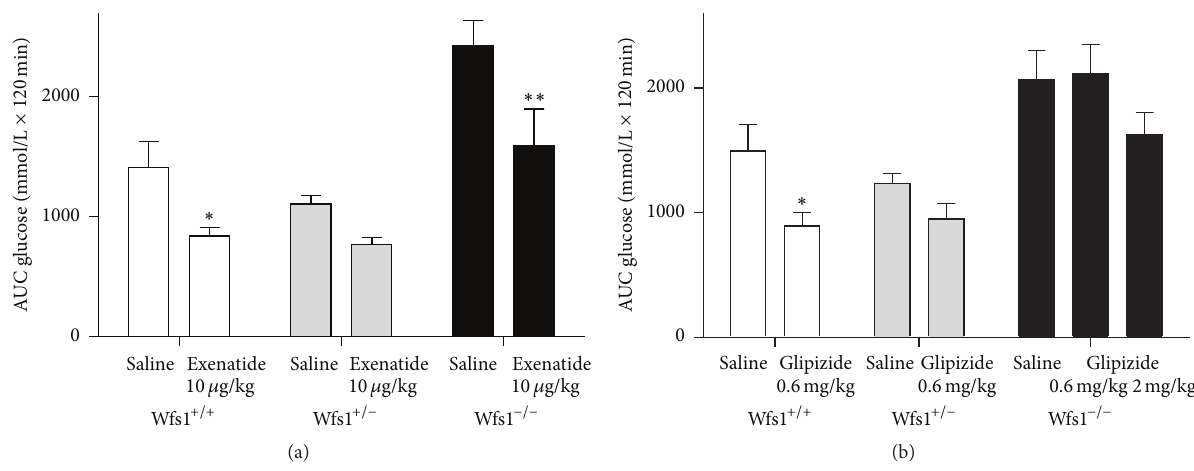
Figure 4: Effect of treatment with exenatide (a) and glipizide (b) on glucose AUC during IPGTT. Wfs1 +/+ , white bars; Wfs1 +/− , grey bars; Wfs1 −/− , black bars. Two-way ANOVA was used, followed by Duncan post hoc test, where ∗ 𝑝 < 0.05 versus saline; ∗∗ 𝑝 < 0.01 versus saline. 𝑛 = 8 in all groups.